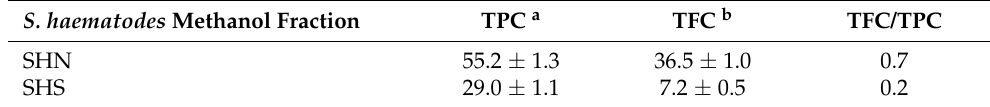
Table 4. Total phenol content (TPC) and total flavonoid content (TFC) of S. haematodes